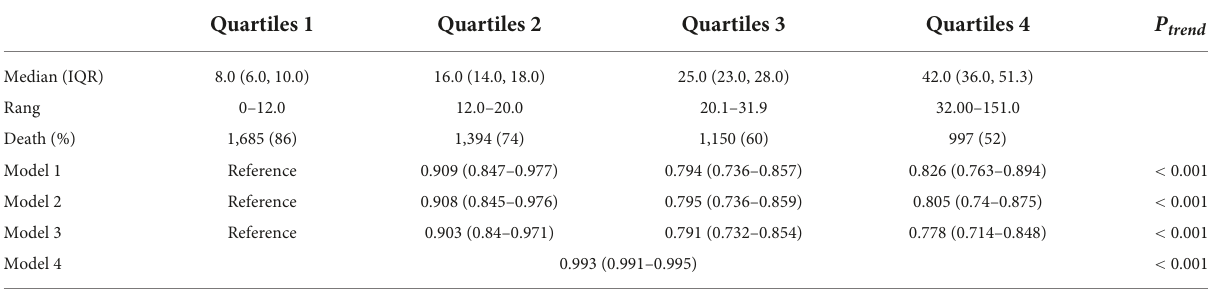
TABLE 2 All-cause mortality according to quartiles of serum lycopene concentrations among patients with CKD. Quartiles of serum lycopene level ( µ g/dl)